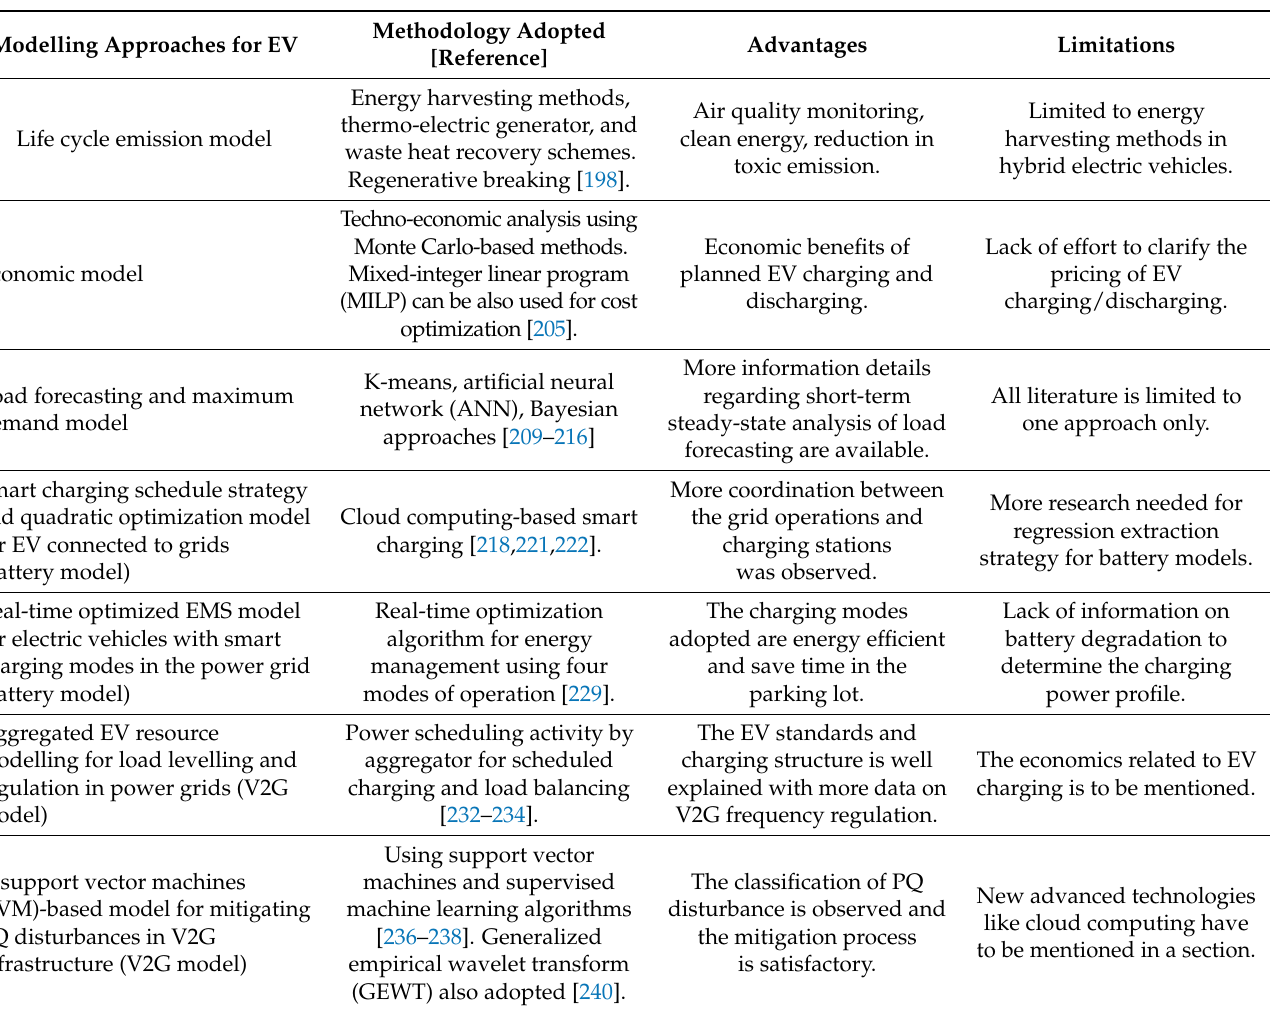
Table 6. Categorization of modelling electric vehicles based on methodology, advantages, and